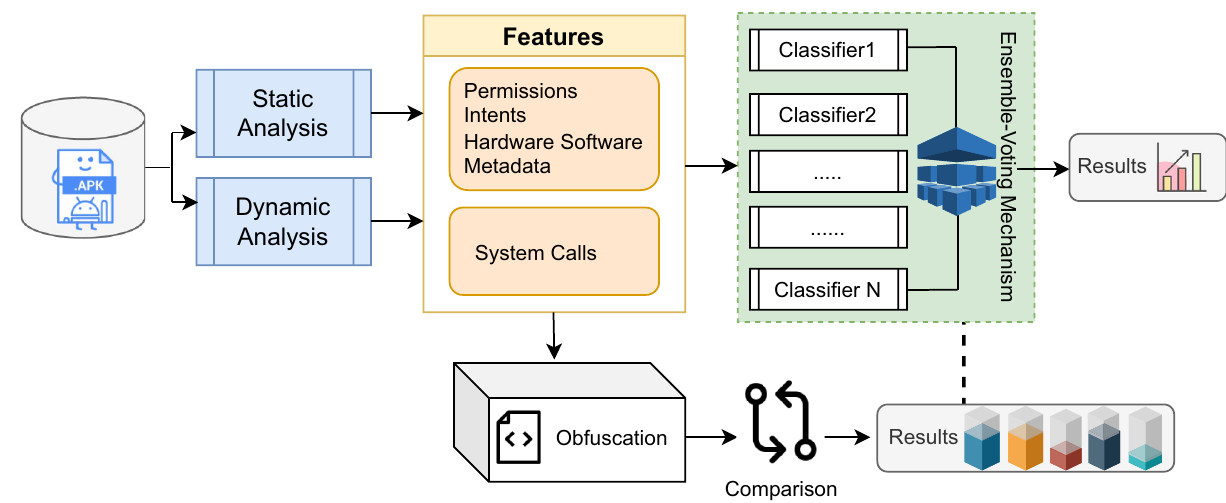
Figure 1. Proposed approach